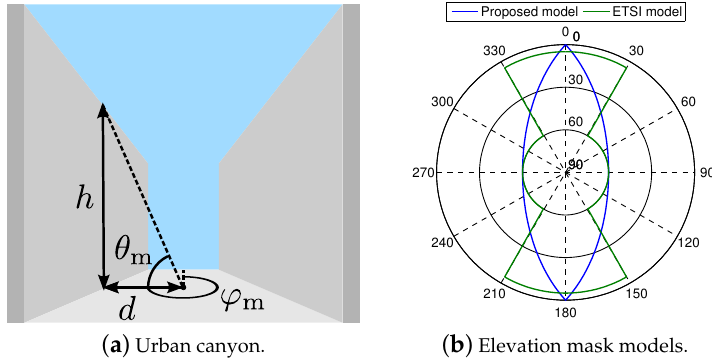
Figure 2. Definition of the urban canyon parameters and the sky plot of its elevation mask, according to ETSI TS 103.246-3 [13] and the proposed